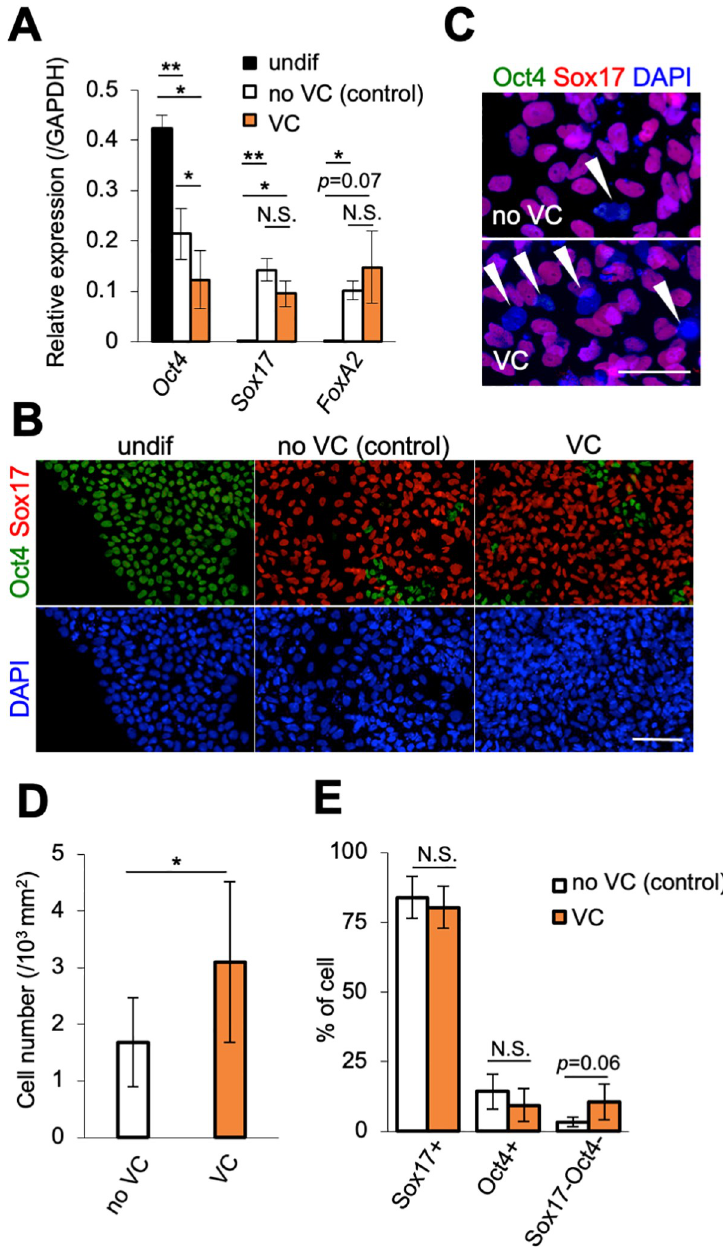
Fig 2. Analysis of differentiation into endoderm at stage 1. ( A ) qRT-PCR analysis of the expression of Oct4 , Sox17 and FoxA2 , normalized against GAPDH at stage 1. undif (undifferentiated cells), black; no VC (control), white; VC (vitamin C-treated), orange. Horizontal bars indicate statistical analyses. � p < 0.05, �� p < 0.01, N.S. not significant; paired t -test. ( B, C ) IHC for Oct4 (green) and Sox17 (red) at stage 1. A higher magnification of no VC (control) and VC (vitamin C-treated) cells was shown in ( C ). Arrowheads in C indicate cells expressing neither Oct4 nor Sox17 (blue cells). Nuclei were stained with DAPI (blue). Scale bars: 100 μ m ( B ), 50 μ m ( C ). ( D ) The number of cells in 1 mm 2 foci from the monolayer region. no VC, white; VC (vitamin C-treated), orange (n = 6, including two biological and three technical replicates). � p < 0.05; paired t -test. ( E ) Percentage of cells expressing Sox17 (Sox17+), Oct4 (Oct4+) and neither Sox17 nor Oct4 (Sox17-/Oct4-). no VC (control), white; VC (vitamin C-treated), orange (n = 6, including two biological and three technical replicates). Statistical analysis was performed by paired t -test.